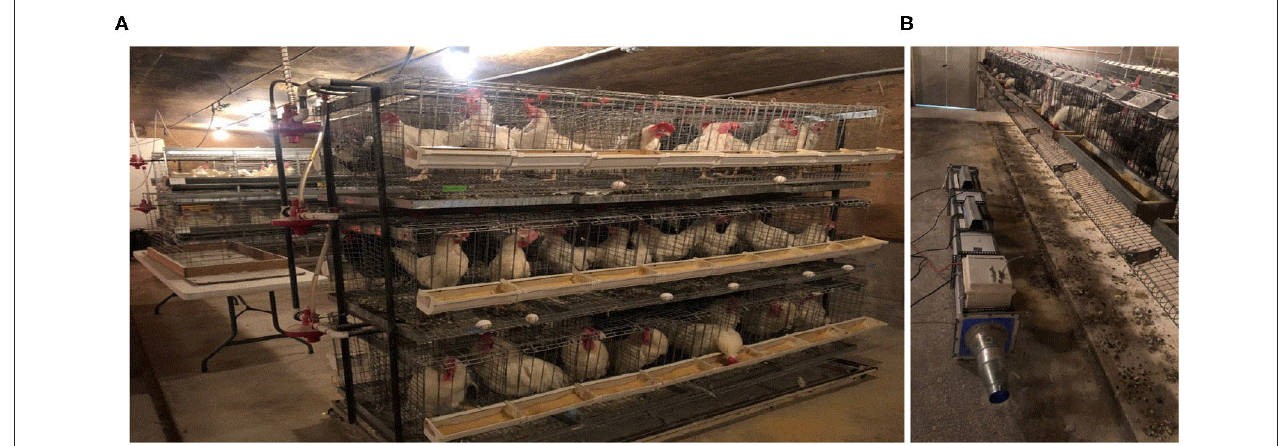
FIGURE 4 | Pilot-scale mitigation was tested on a teaching poultry farm. (A) Interior of the teaching poultry barn, (B) UV-A